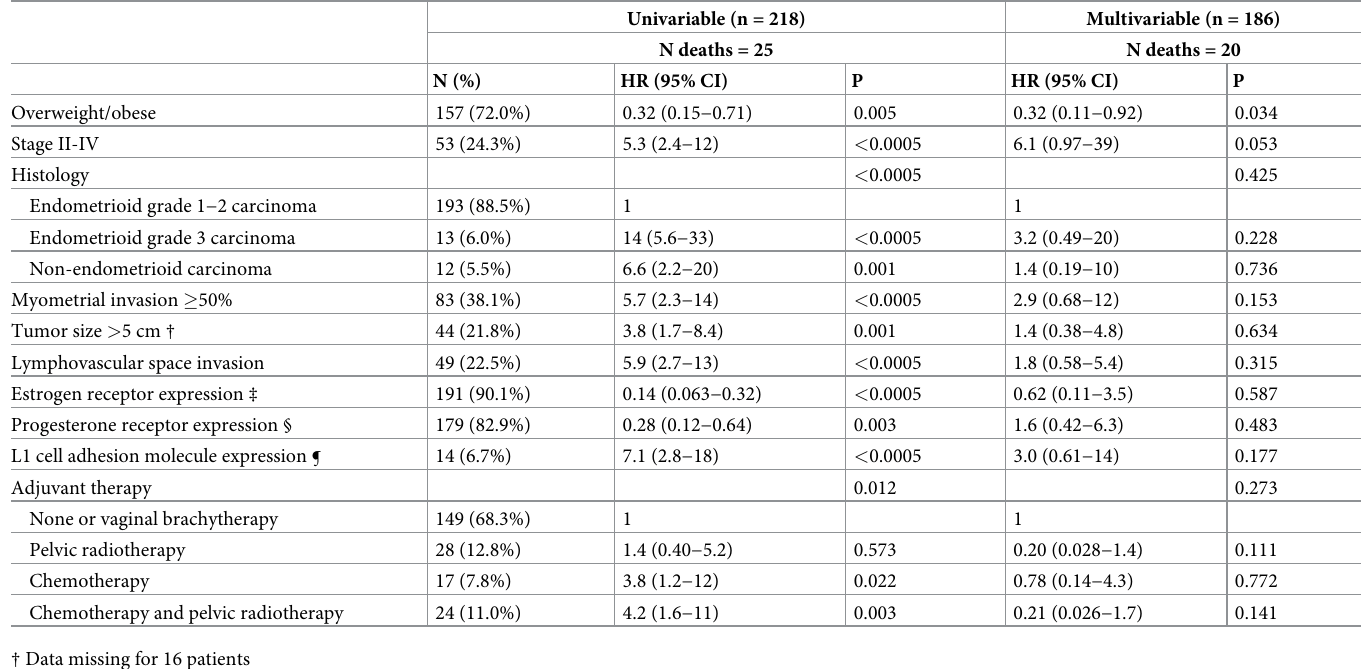
Table 4. Univariable and multivariable Cox regression analyses of cancer-related mortality for the “no specific molecular profile”